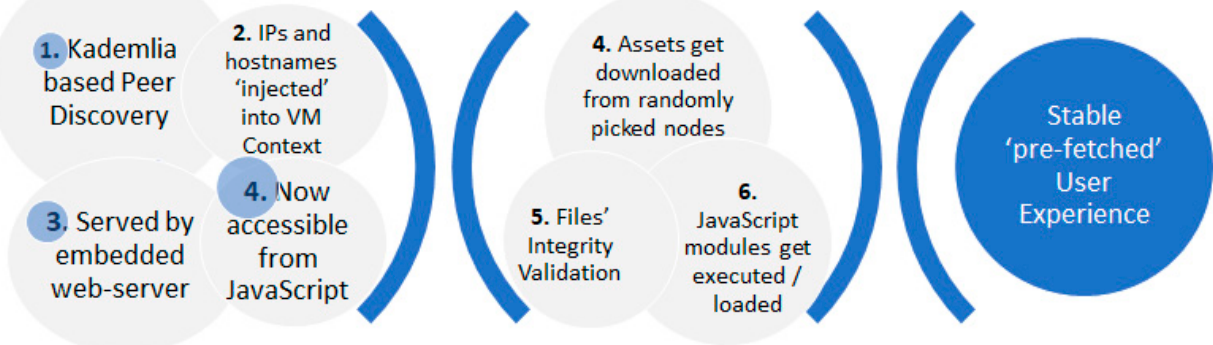
Figure 4 . Steps to be taken by the decentralized bootloader (UI).